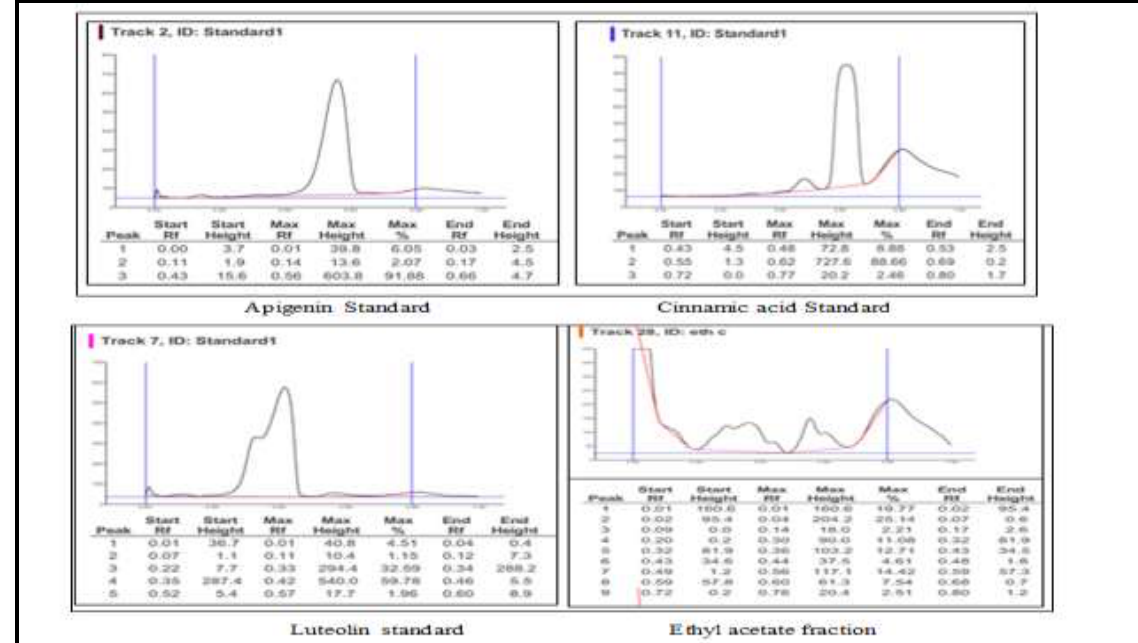
Figure 2. HPTLC chromatography show max R f value for standards and